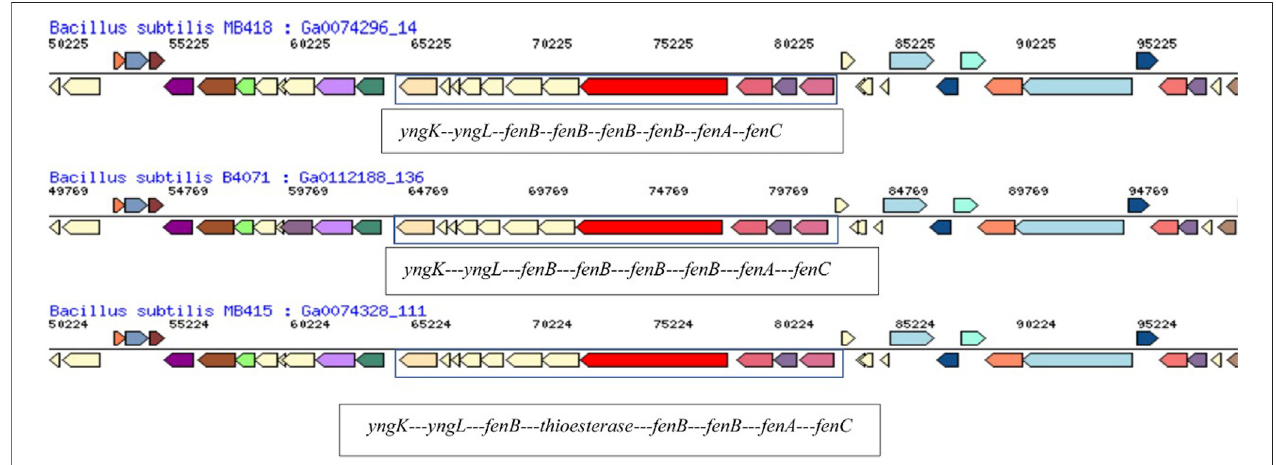
FIGURE 7 | Comparison of the hydrocarbon-degrading gene locus fen operon of Bacillus subtilis MB415, MB418, and other Bacillus species.